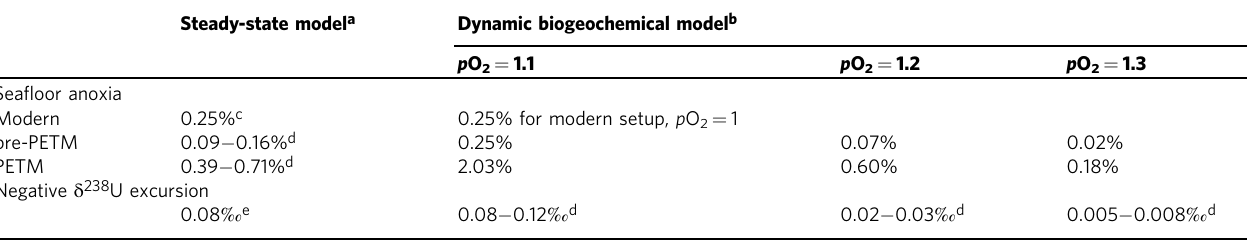
Table 1 Model results comparing steady-state and dynamic model solutions for anoxia and U cycle